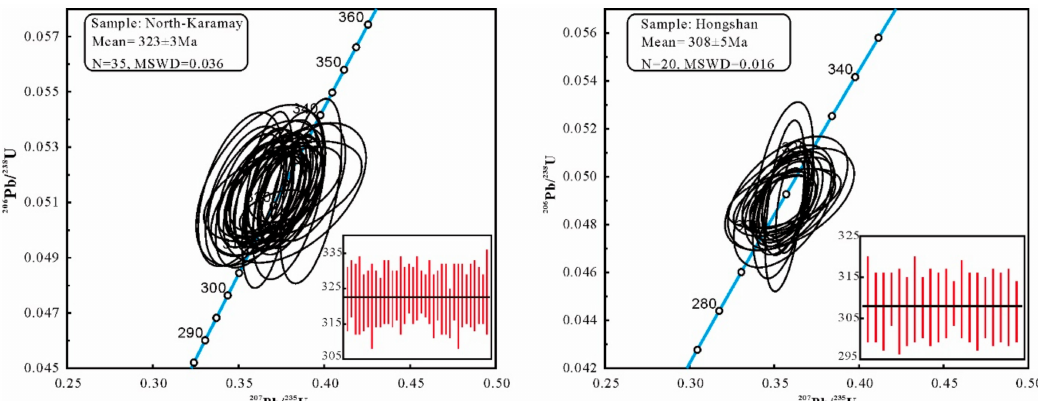
Figure 5. U-Pb concordia diagrams showing zircon ages obtained by laser-ablation inductively-coupled- plasma mass spectrometry (LA-ICP-MS) for the granitic batholiths in North Junggar.